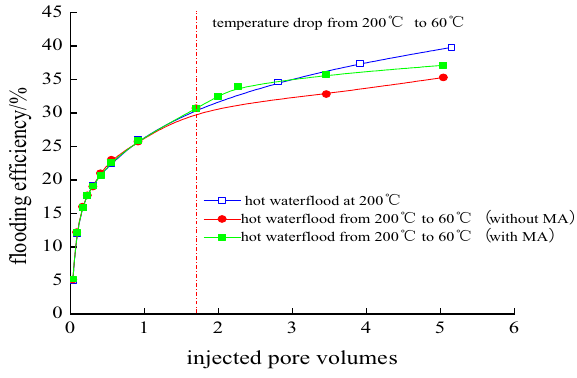
Fig. 7 Relationship curve of viscosity–temperature of crude oil from